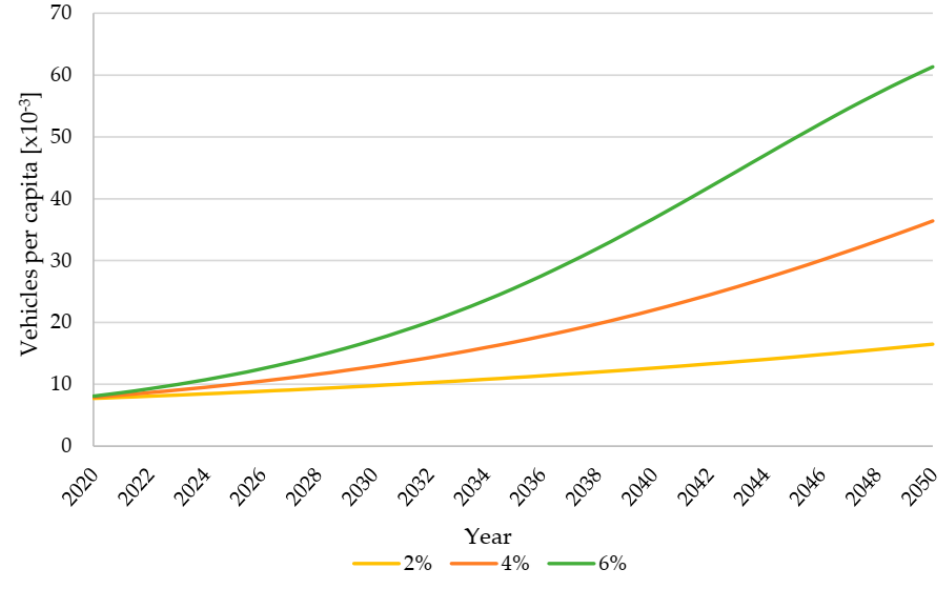
Figure 3. Motorization index by varying